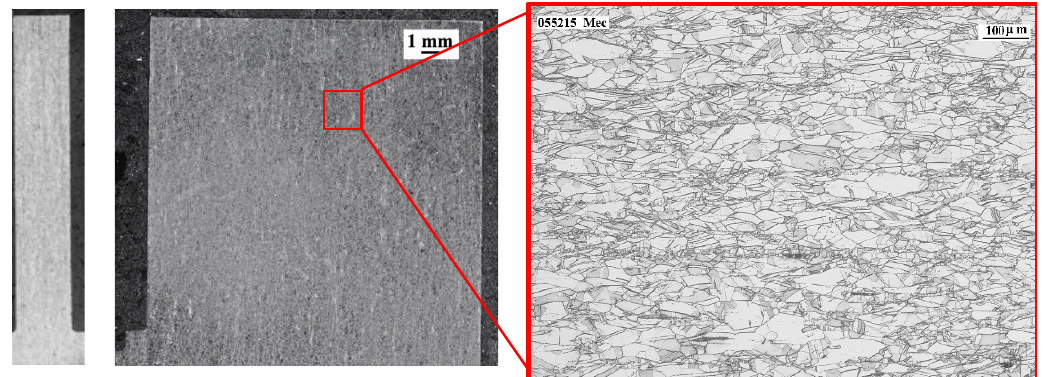
Figure 7. Macrographs and microstructure of the wall manufactured by forged-SA.